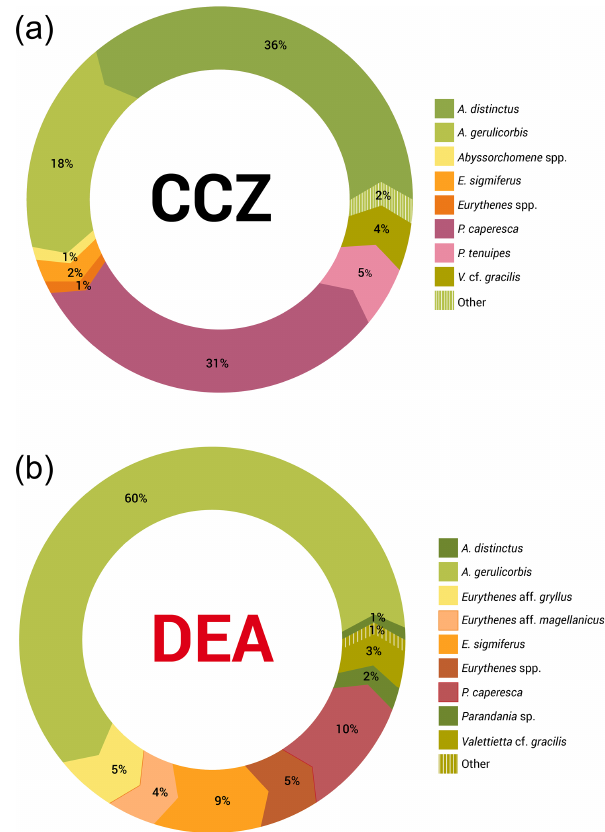
Figure 5. Relative species abundances in the Clarion–Clipperton fracture zone and the DisCOL experimental area. These abundances represent the longer than 15mm subsample of the scavenging am- phipod community. Table 3. Comparison of biodiversity calculated using the Simpson index ( D ) for the Clarion–Clipperton fracture zone and DisCOL experimental area and D for each station is shown for further com- parisons within these